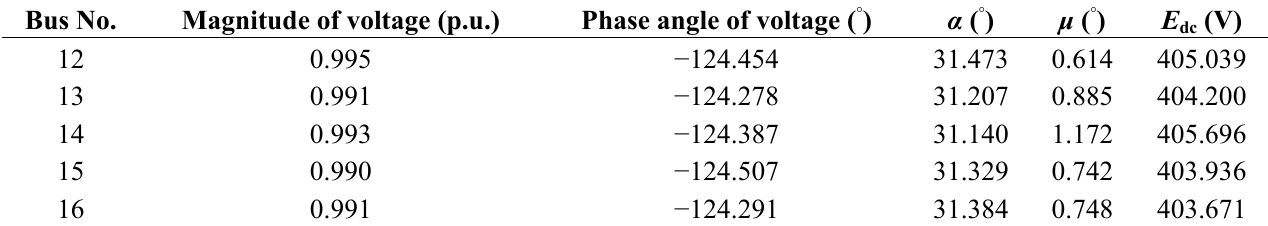
Table 3. The parameter values of nonlinear loads without wind farm. Bus